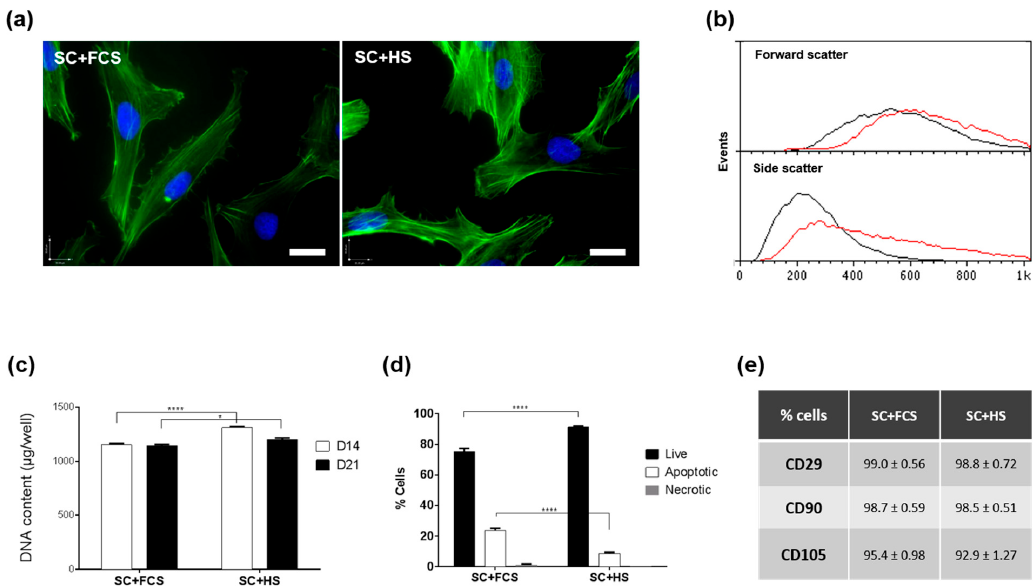
Figure 1. Characterisation of mesenchymal stem cells cultured in fetal calf serum (FCS) and human serum (HS) based medium (SC) over 21 days. ( a ) Fluorescence images of phalloidin-stained MSCs ( green ) cultured in SC + FCS or SC + HS with DAPI nuclear counterstain ( blue ). Scale bar = 50 µ m. ( b ) Representative flow cytometry histograms showing the size (Forward scatter, top) and granularity (Side Scatter, bottom) profiles for cultures after two passages in SC + FCS (black) and SC + HS (red). ( c ) DNA quantitation after culture in SC + FCS and SC + HS for 14 ( white ) and 21 days ( black ) ( n = 6). ( d ) Annexin-V analysis of live, apoptotic and necrotic MSC fractions after 14 days in Standard Culture (SC) medium containing FCS or HS ( n = 3). * p < 0.05 and **** p < 0.00005. ( e ) Flow cytometry analysis of MSC surface marker CD29, CD90 and CD105 expression in cells cultured for two passages in SC +